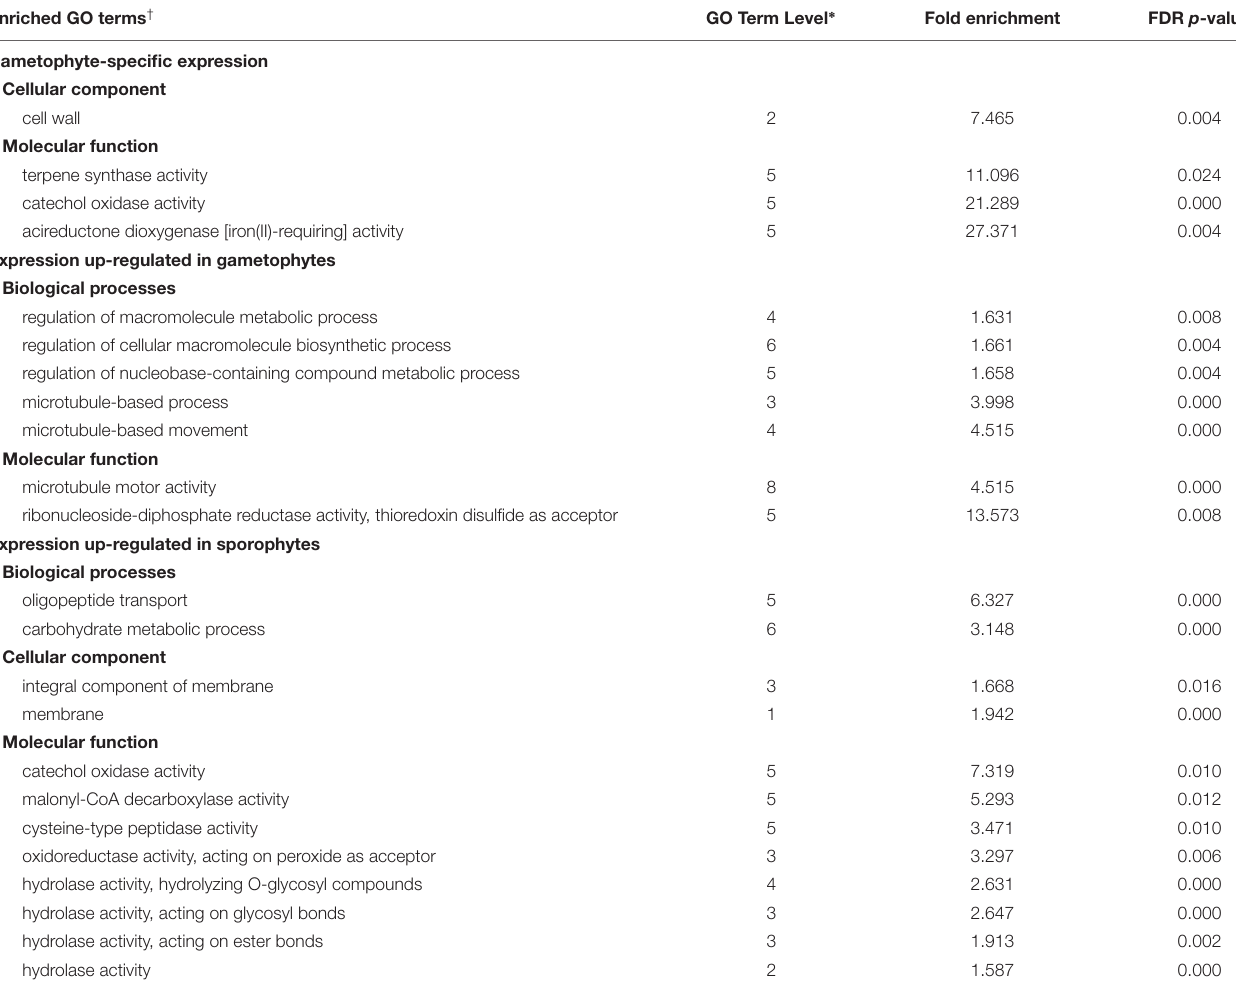
TABLE 1 | Summary of the most highly enriched Gene Ontology (GO) terms for categories of differentially expressed genes at a threshold of log2FC ≥ 2 and padj ≤